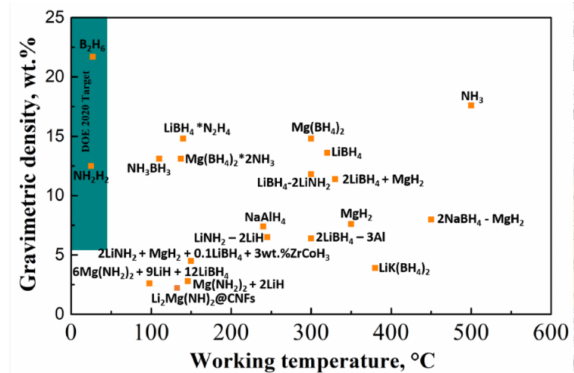
Figure 11. Working gravimetric density and temperatures of some representative materials for hydrogen storage applications.